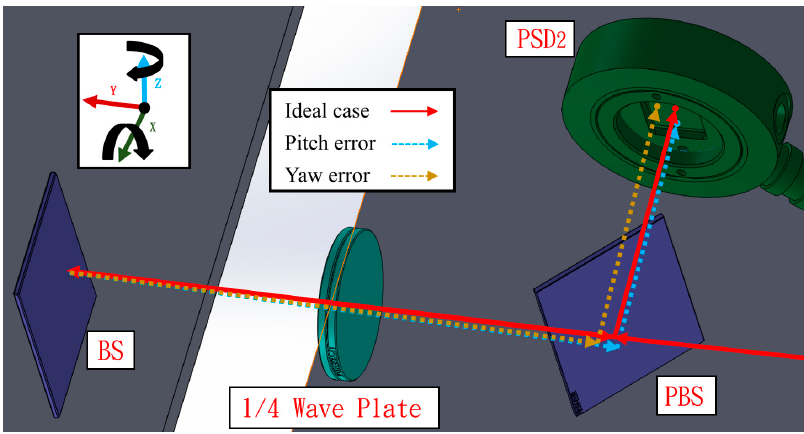
Figure 4. Light path with pitch error or yaw error.